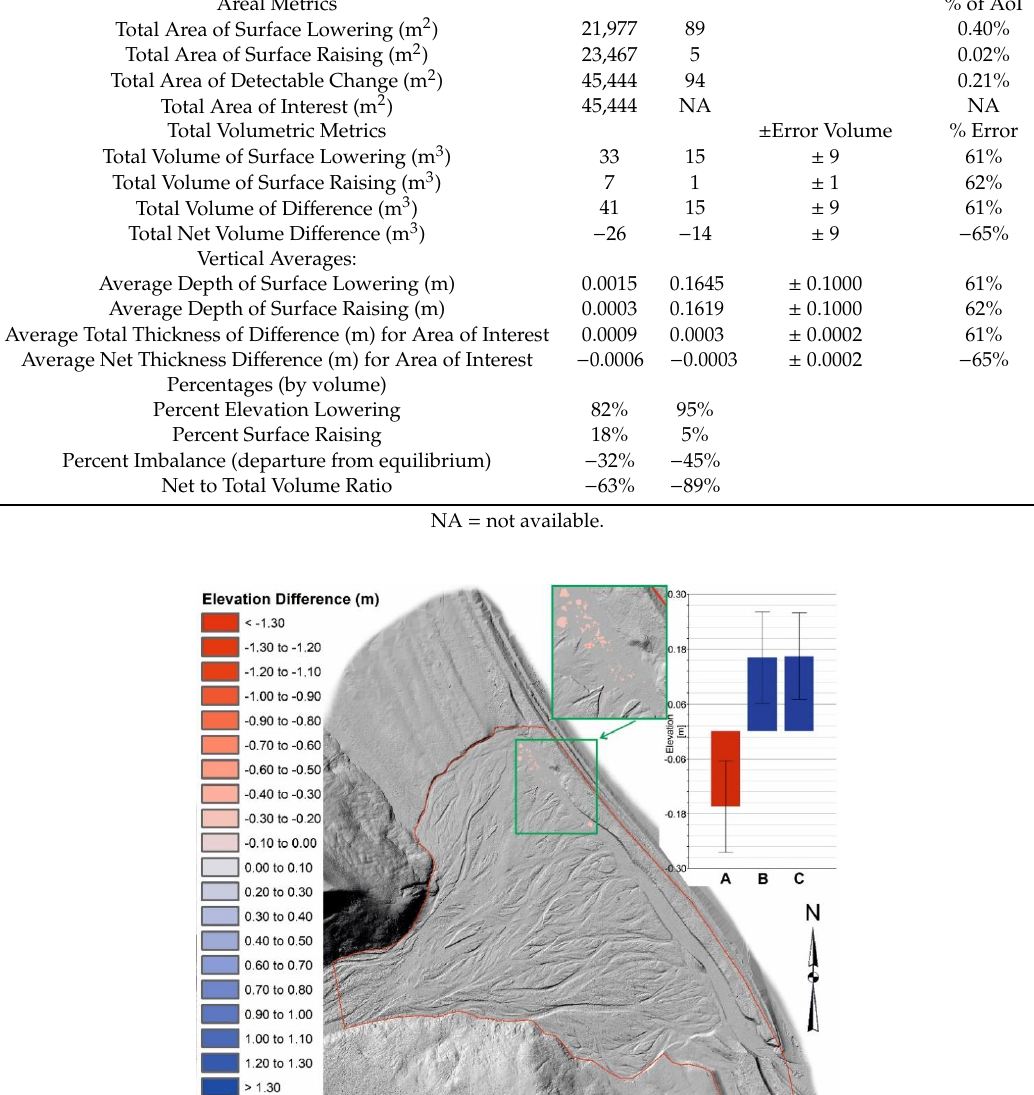
Table 3. Changes in physical parameters of the Area of Interest in July 2013 calculated volumetrically with reference to the total volume of the gravel-cobble material’s net change recorded by the DoD (both lowering and raising) from the manually cleaned-up (new) to the CSF-filtered (old) DTM. The uncertainty analysis was calculated by simply using the minimum level of detection (minLoD) approach while accounting for a uniform error of 0.1 m.